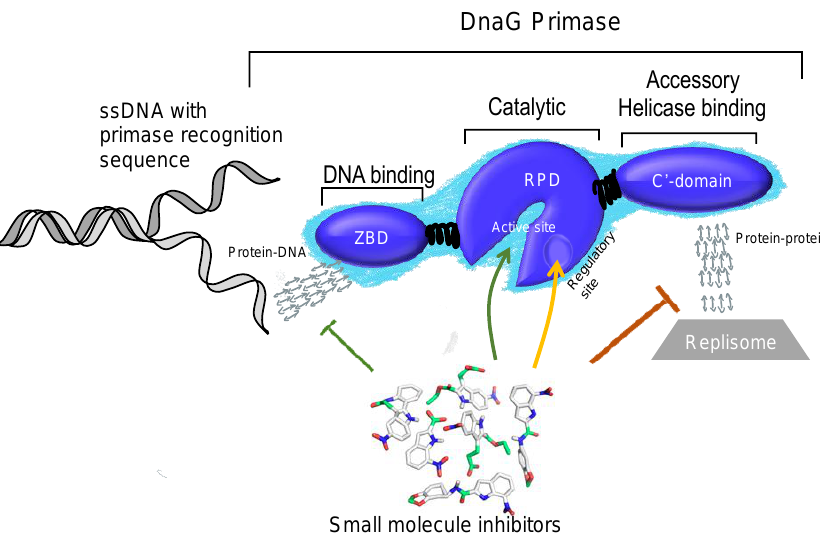
Figure 4. Possible strategies to halt DNA replication through the inhibition of DNA primase: (1) by inhibiting catalytic activity of RNA primers formation; (2) by disrupting the essential protein-protein interactions primase has with other components of the replisome or outside the replisome; (3) by allosteric regulation; and (4) by the prevention of specific DNA recognition.